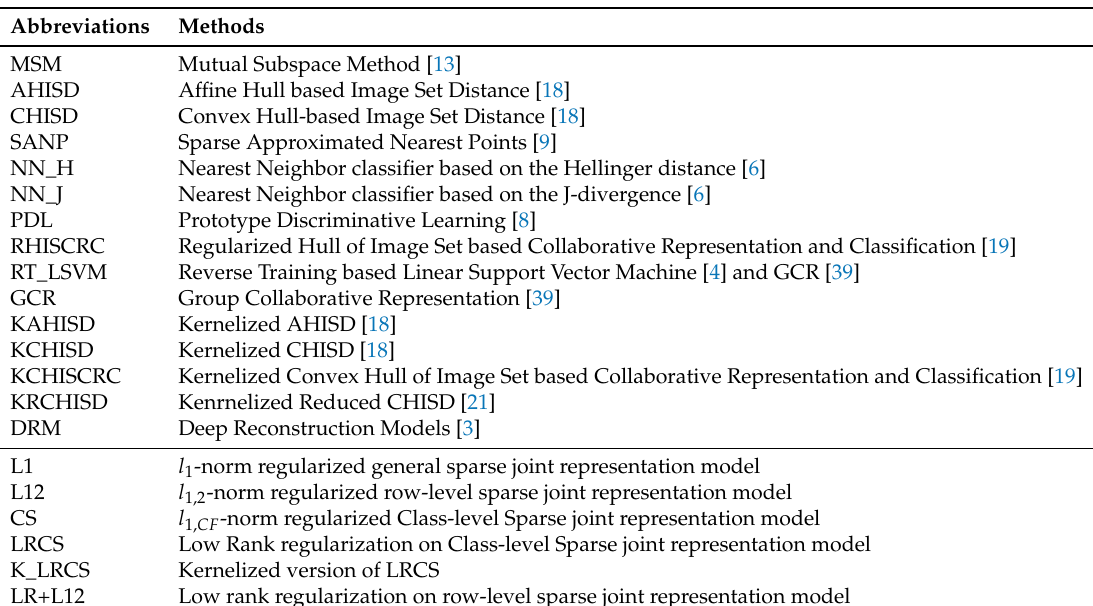
Table 1. Some compared methods/different joint representation models vs. their abbreviations.